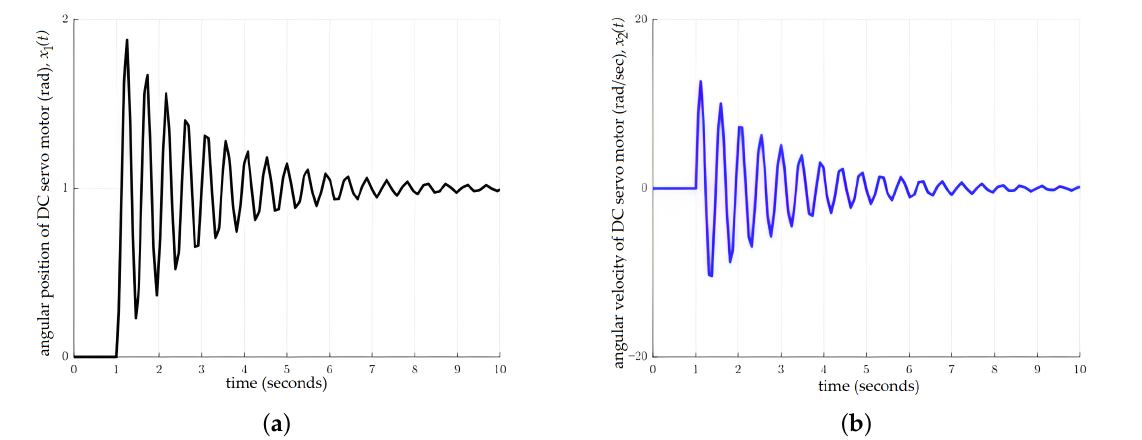
Figure 7. Closed-loop step response for position ( a ) and velocity ( b ) of the DC servo